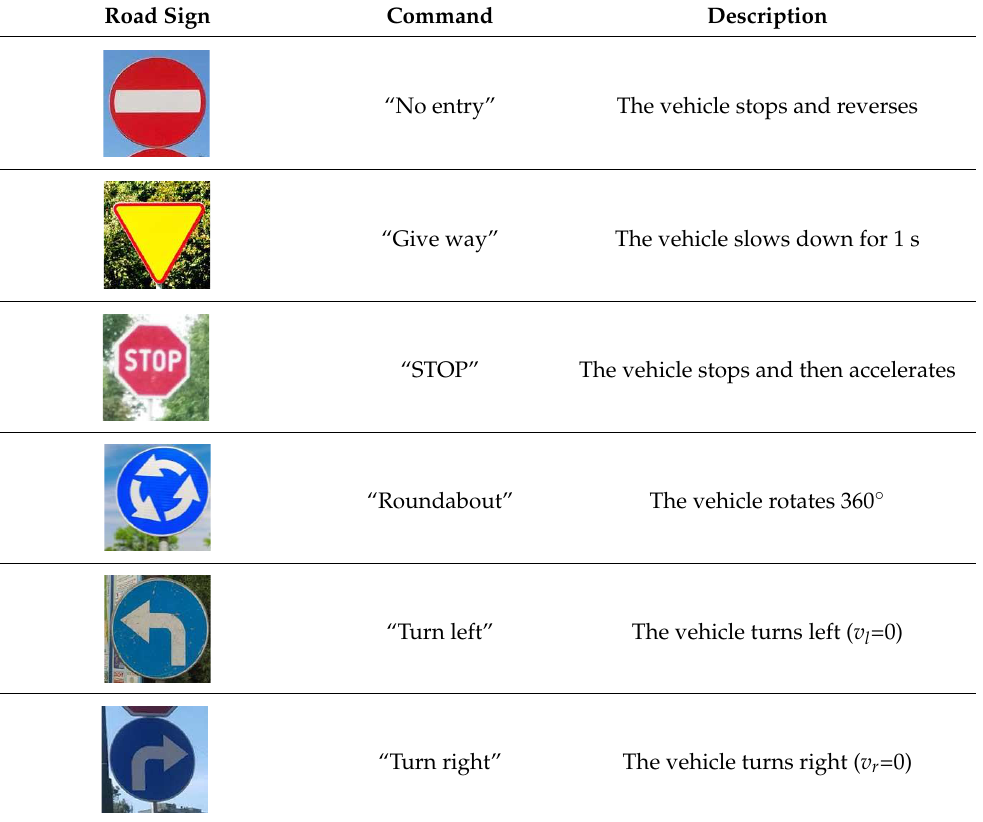
Figure 11. Scheme of vision system processing. Table 3. The rules assumed for the neural classifier.